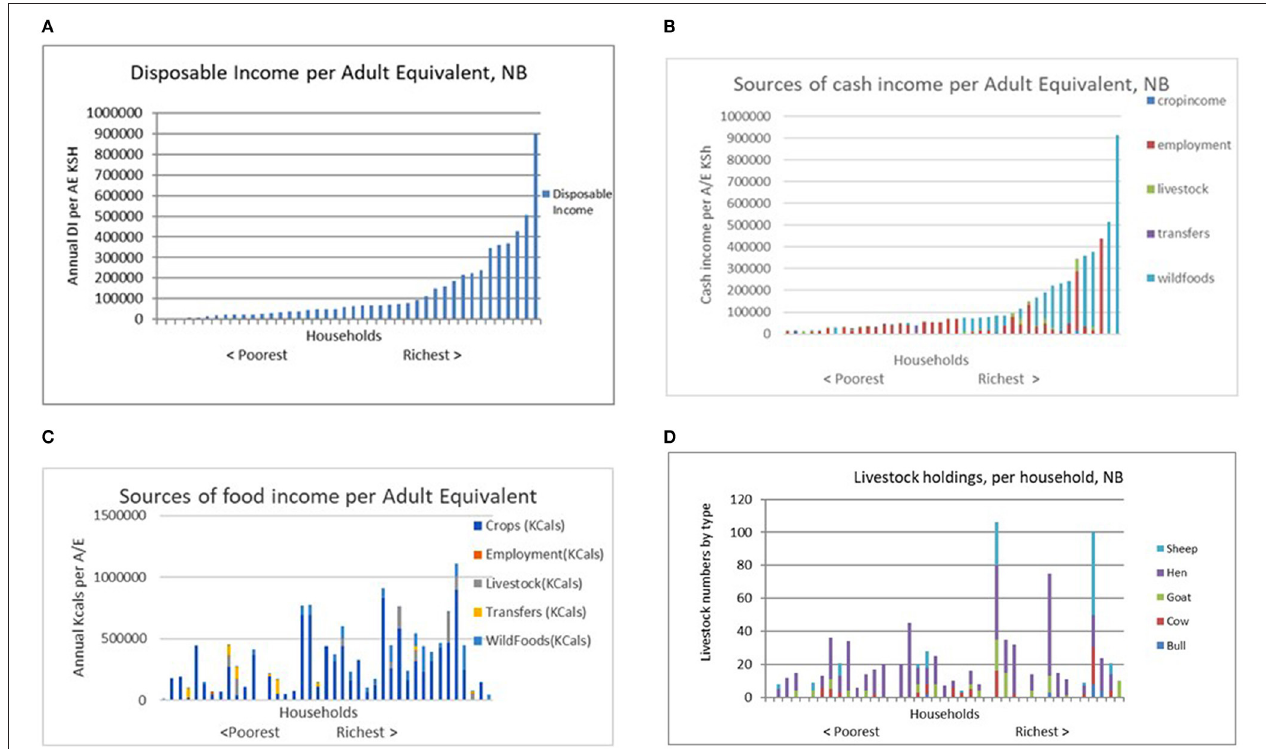
FIGURE 4 | Disposable Income, Cash Income, Food Income and Livestock holdings: Analysis from IHM reports, NB Village, Homa Bay. (A) Indicator: cash available for investment. (B) Indicator: sensitivity to cash income loss in different sectors. (C) Indicator: dependence on market purchase for food security. Annual food energy requirement per adult equivalent is just under 1 million kcals. (D) Indicator: assets, livestock